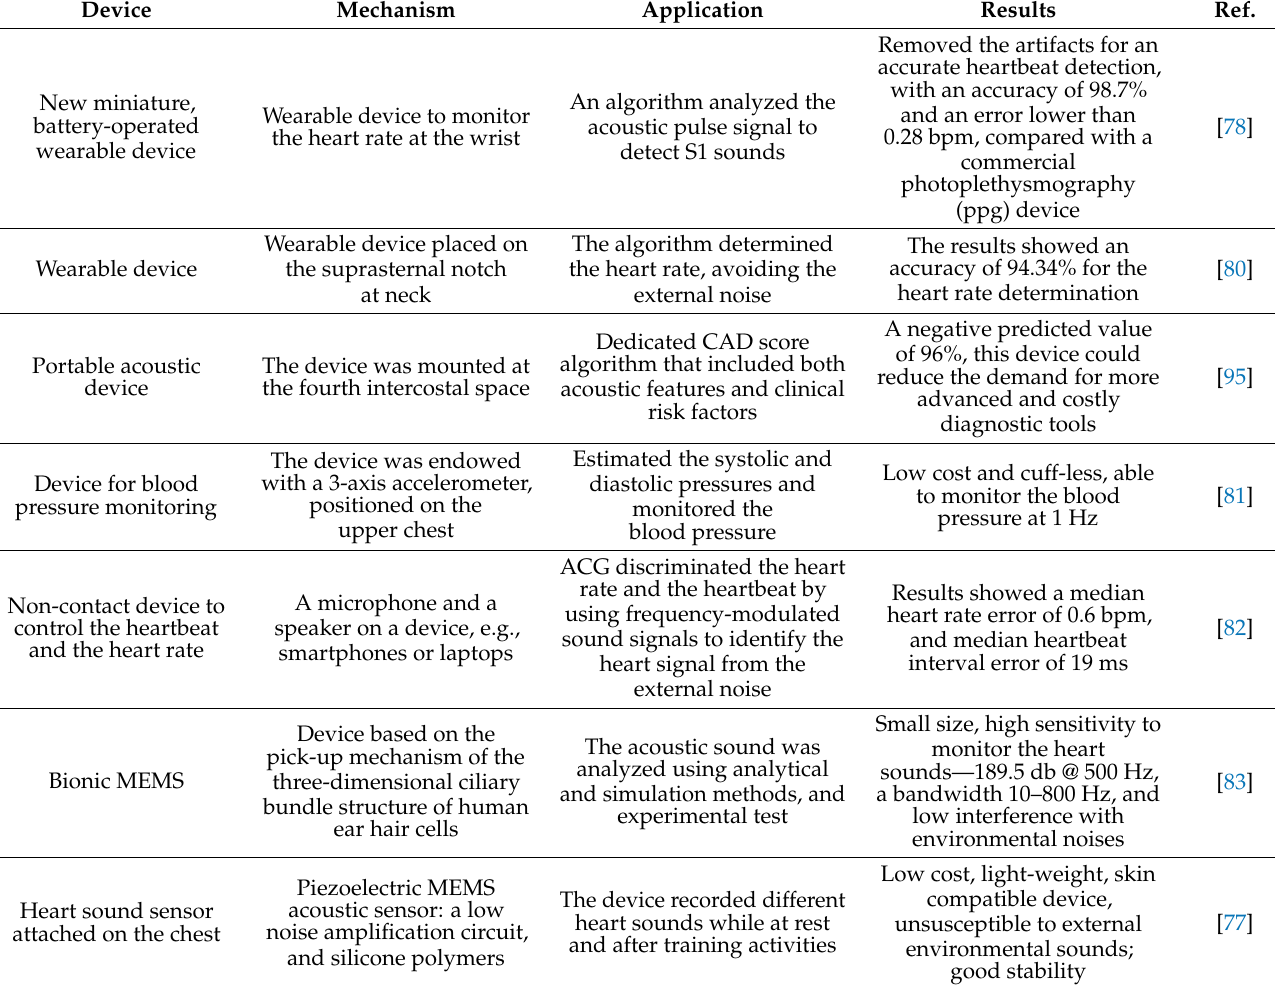
Table 2. Devices to detect heart-related acoustic